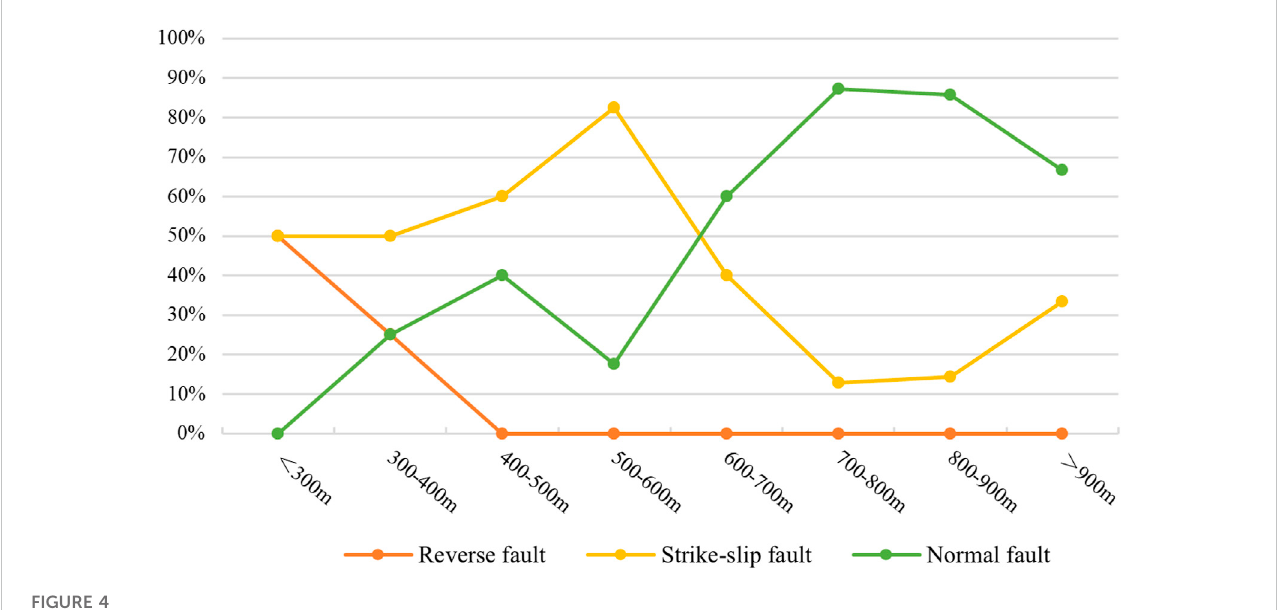
Proportion of different in situ stress states at different